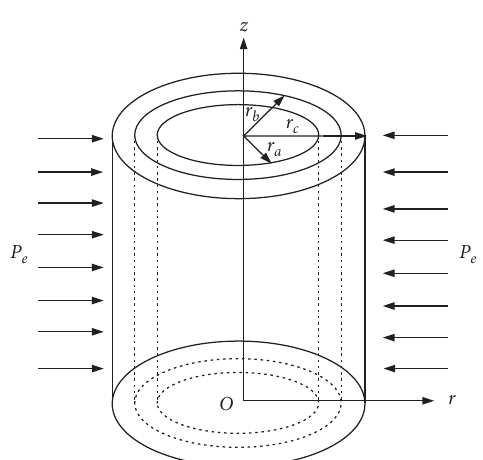
Figure 2: Mechanical model of the